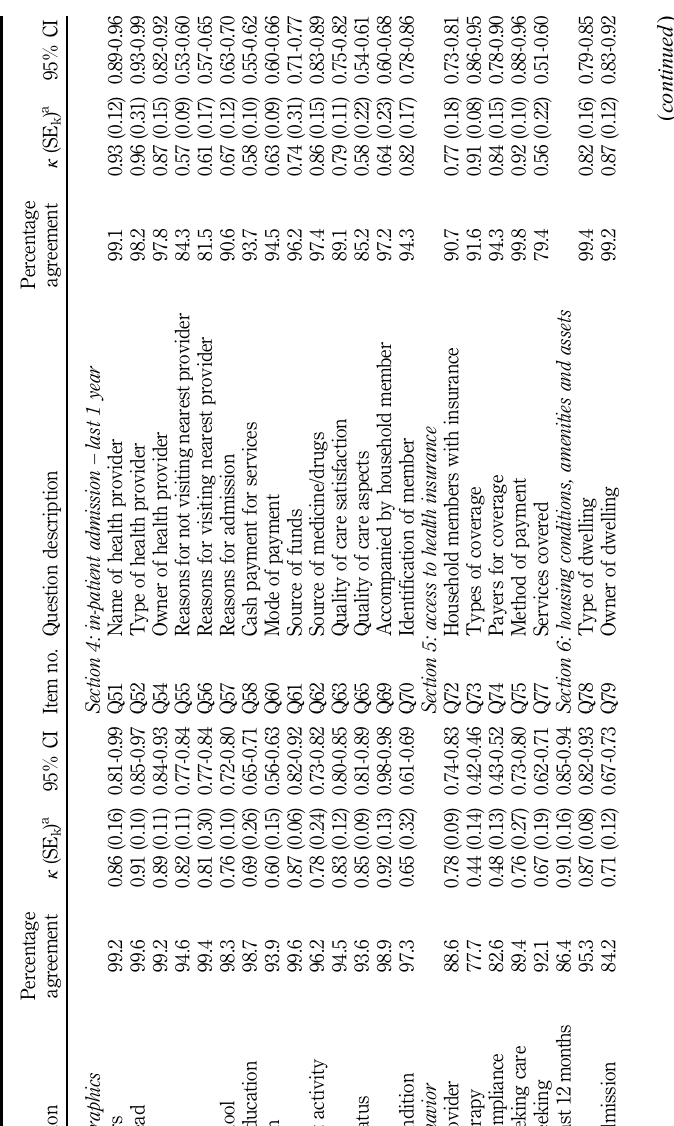
Table III. Test-retest